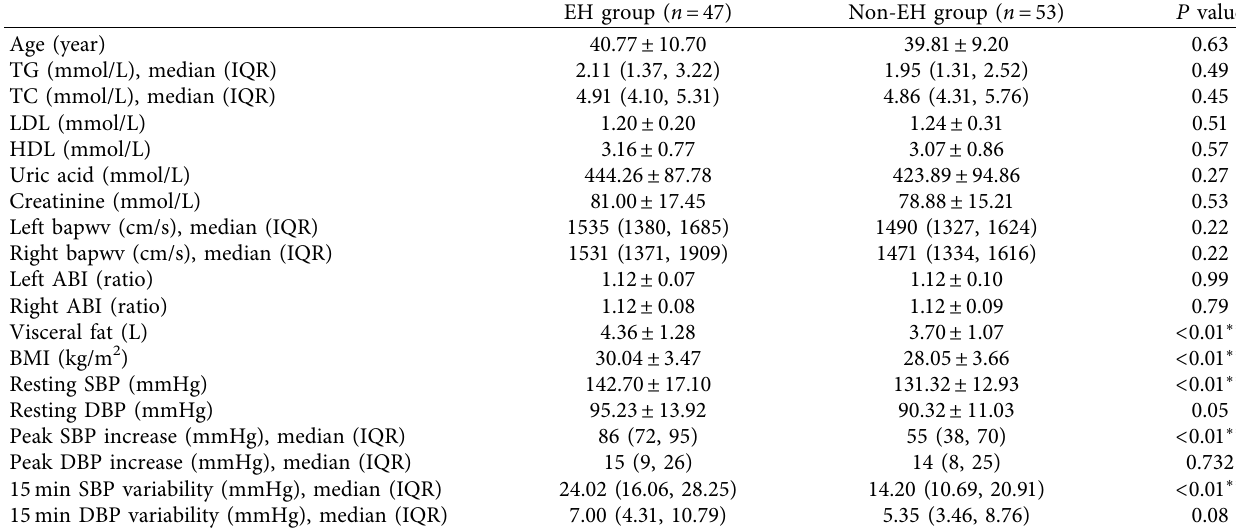
Table 1: Comparison of clinical data between EH group and non-EH group.